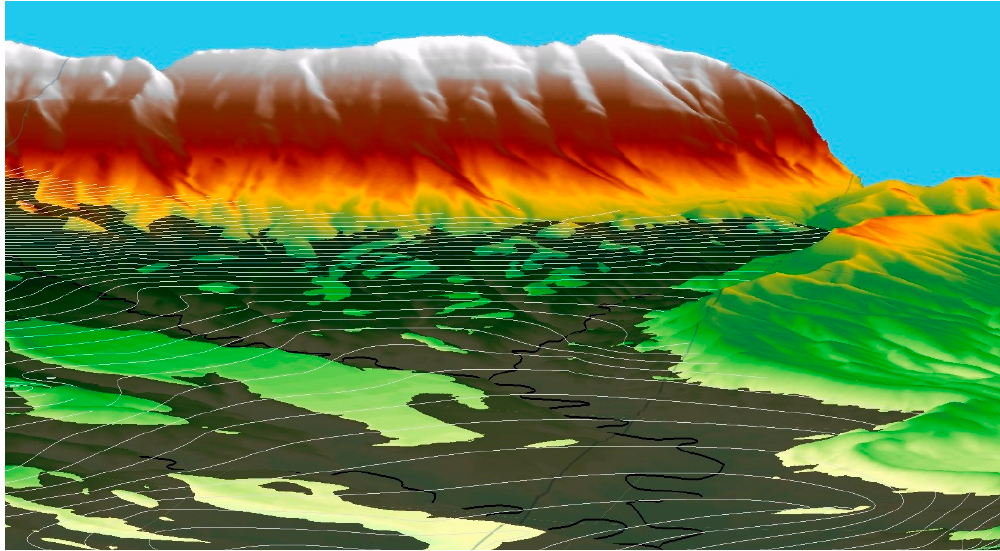
Figure 3. ESRI ArcScene snapshot showing pediment reference surfaces (green-shaded, left) and domains characterized by net volume loss (black-shaded) with regard to the reconstructed late MIS 2 reference surface for the Valle de la Fueva Alta (cf. contour lines).